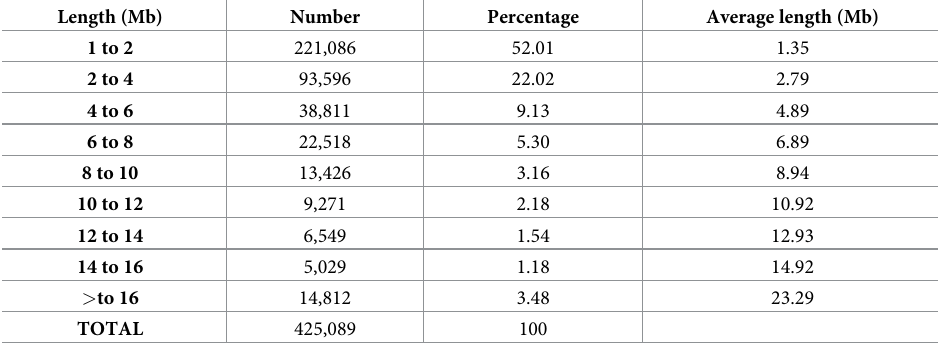
Table 2. Proportion of ROH per length.